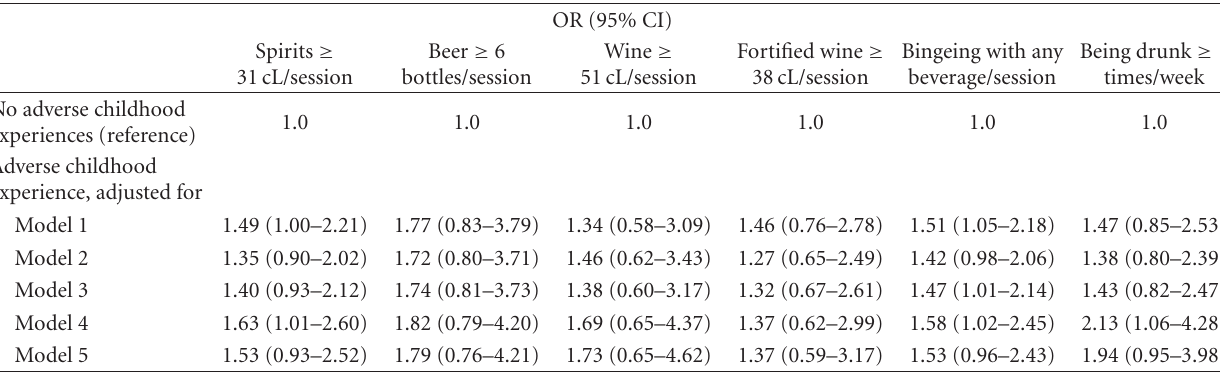
Table 3: Historical childhood data. Odds ratios (OR) of binge-drinking and drunkenness in men with adverse childhood experiences ( n = 207), compared with men without adverse childhood experiences ( n = 632) as a reference group in the KIHD study ( n =